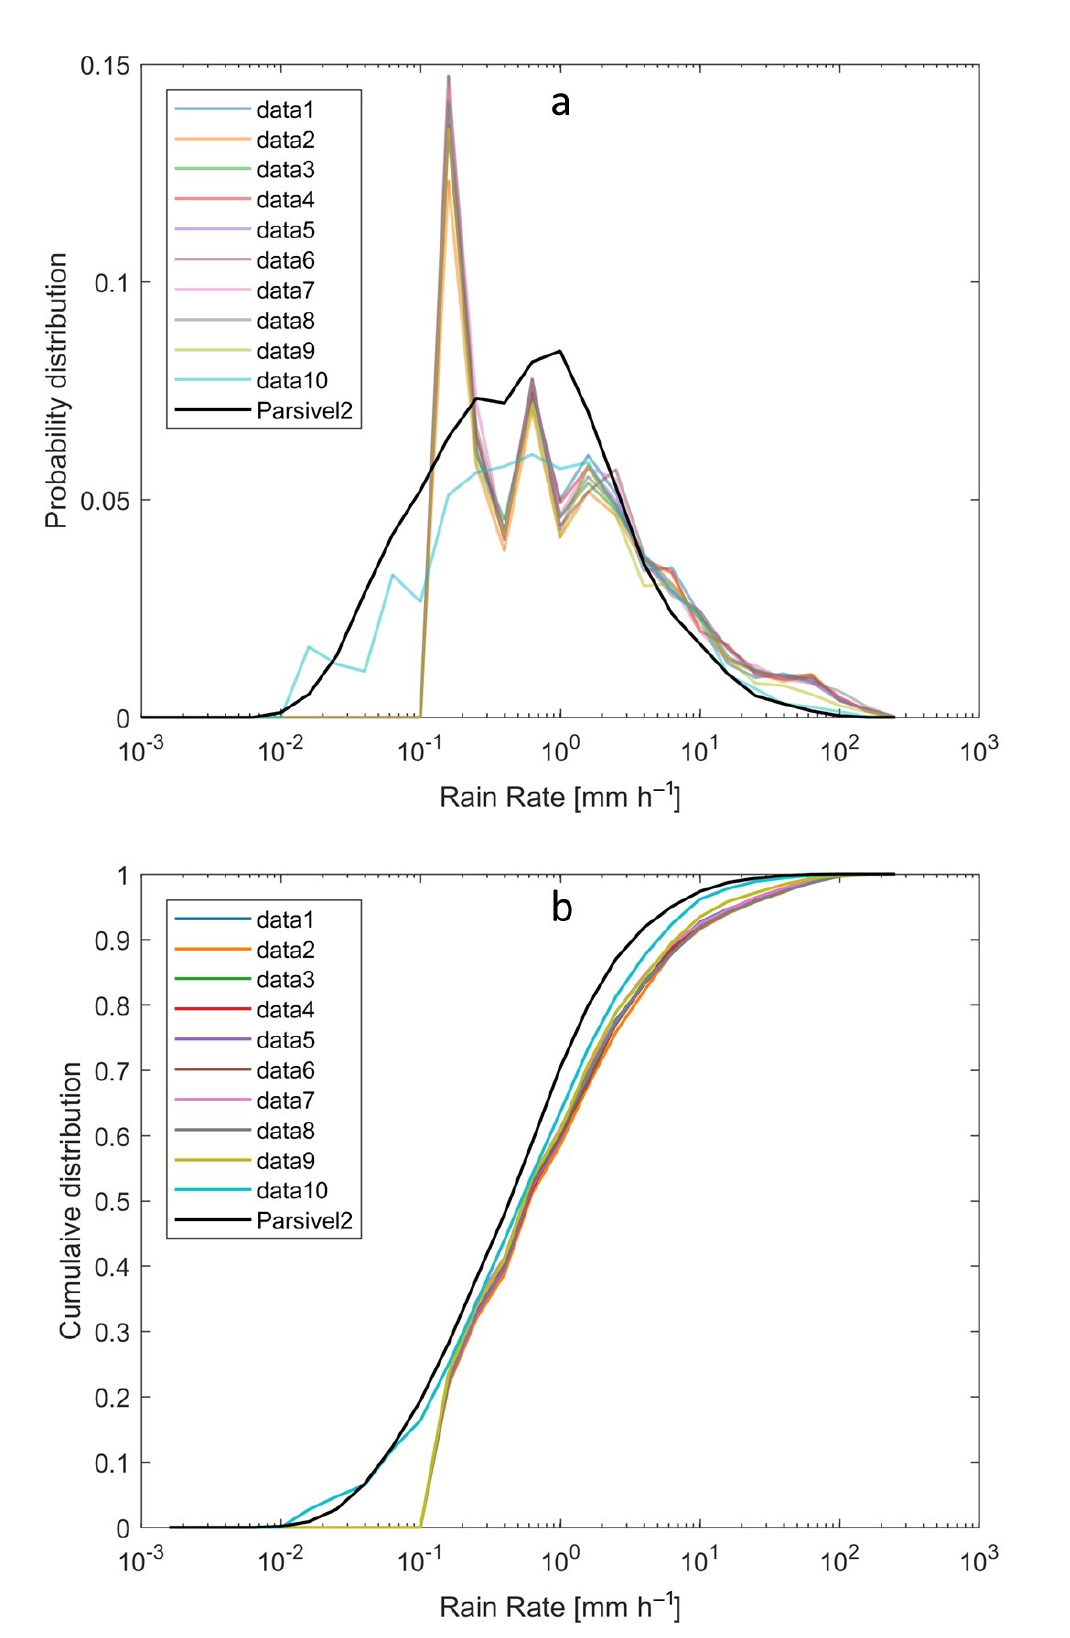
Figure 9. Statistical distribution of rain rate at 1 min sampling output. ( a ) Probability distribution of rain rate. ( b ) Cumulative distribution of rain rate. The Parsivel 2 is shown in black